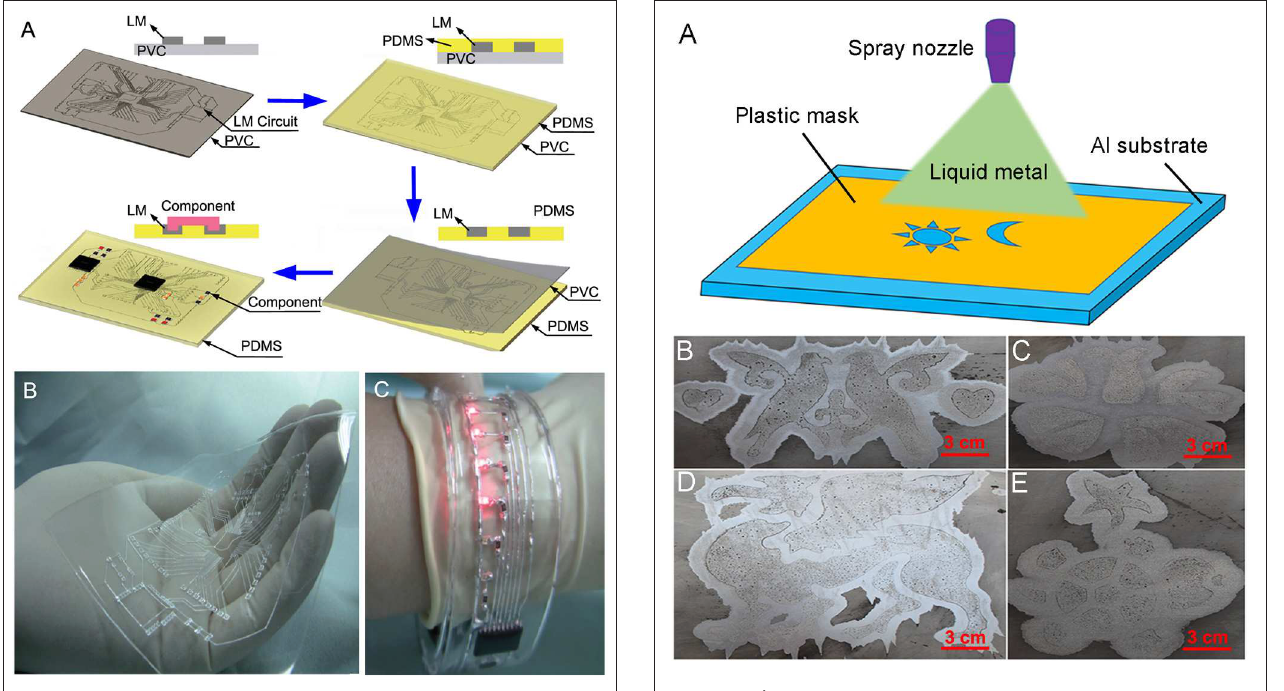
FIGURE 9 | Schematic illustration of liquid metal transfer printing fabrication process (A) , and a printed flexible liquid metal functional circuit encapsulated with PDMS (B) , and a printed wristband circuit in working state (C) . Reproduced with permissions from Wang et al. (2015). Copyright 2015, Wiley-VCH.